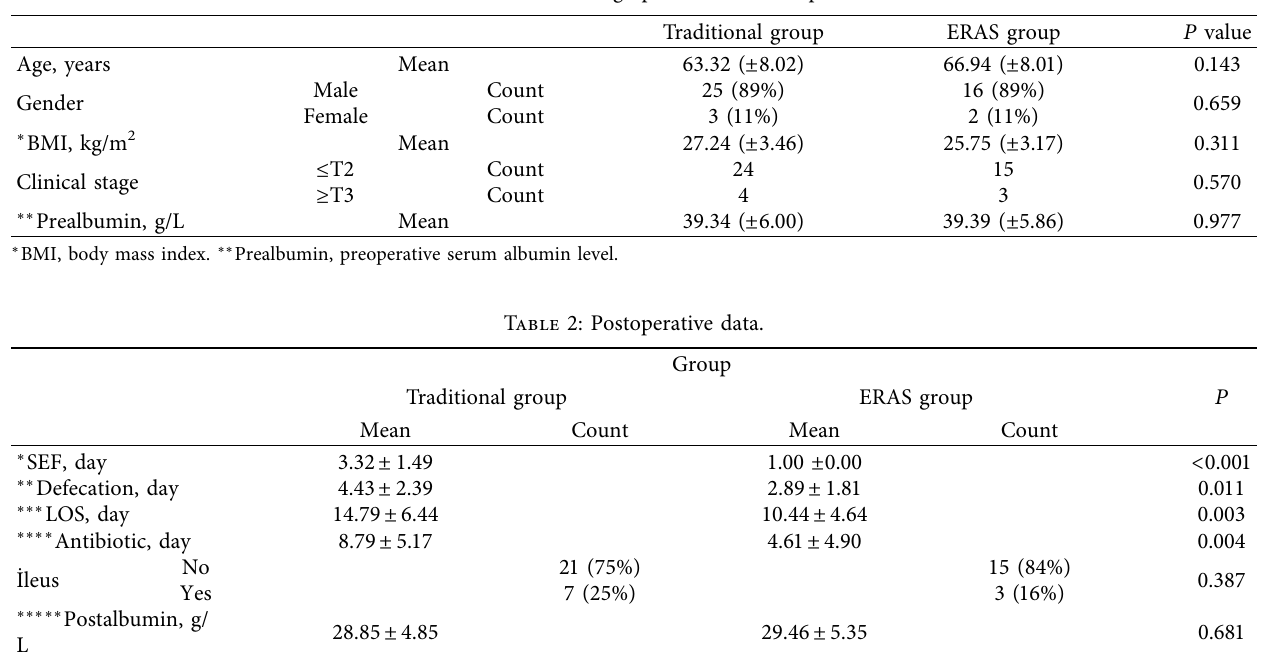
Table 1: Patients demographics and disease profile.